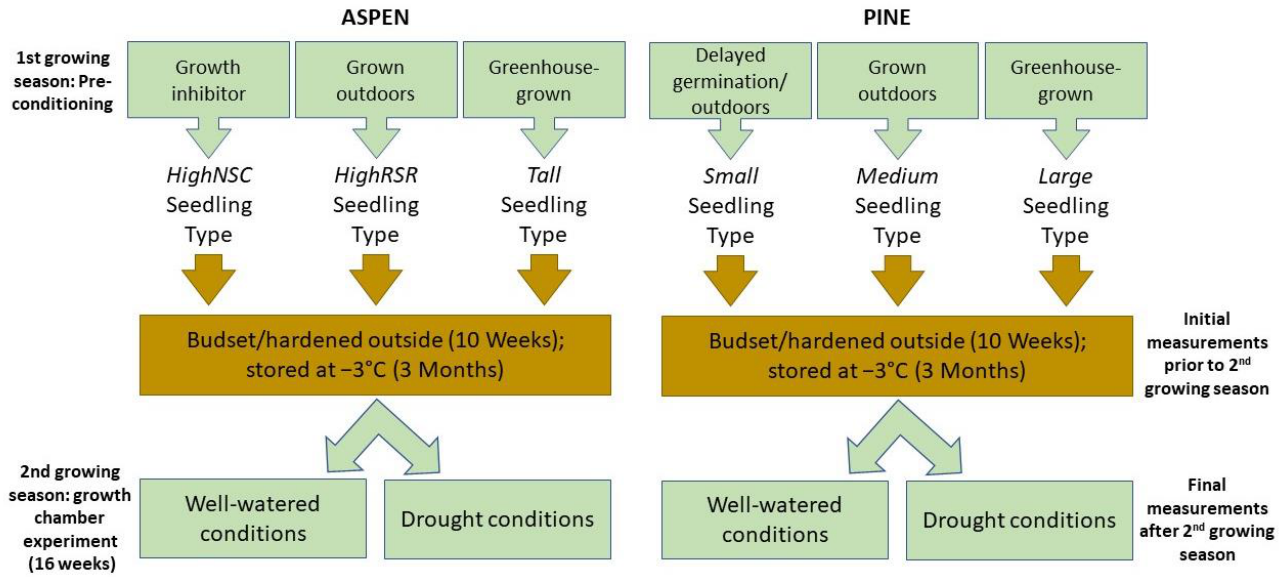
Figure A1. Flow-chart showing a simplified summary and timeline for the whole study; more details on the different steps are provided in the Materials and Methods section. The top row depicts the different seedling preconditioning treatments for aspen ( left ) and pine ( right ) creating three different seedling types for each species. The naming of each of the seedling types is based on the dominant seedling characteristic separating the seedling types from each other (see also Figure A2). All seedlings were hardened, dormant and stored frozen prior to exposing them to drought and well-watered conditions over a second growing season. Seedling characteristics were measured for all seedling types before and after the second growing season.